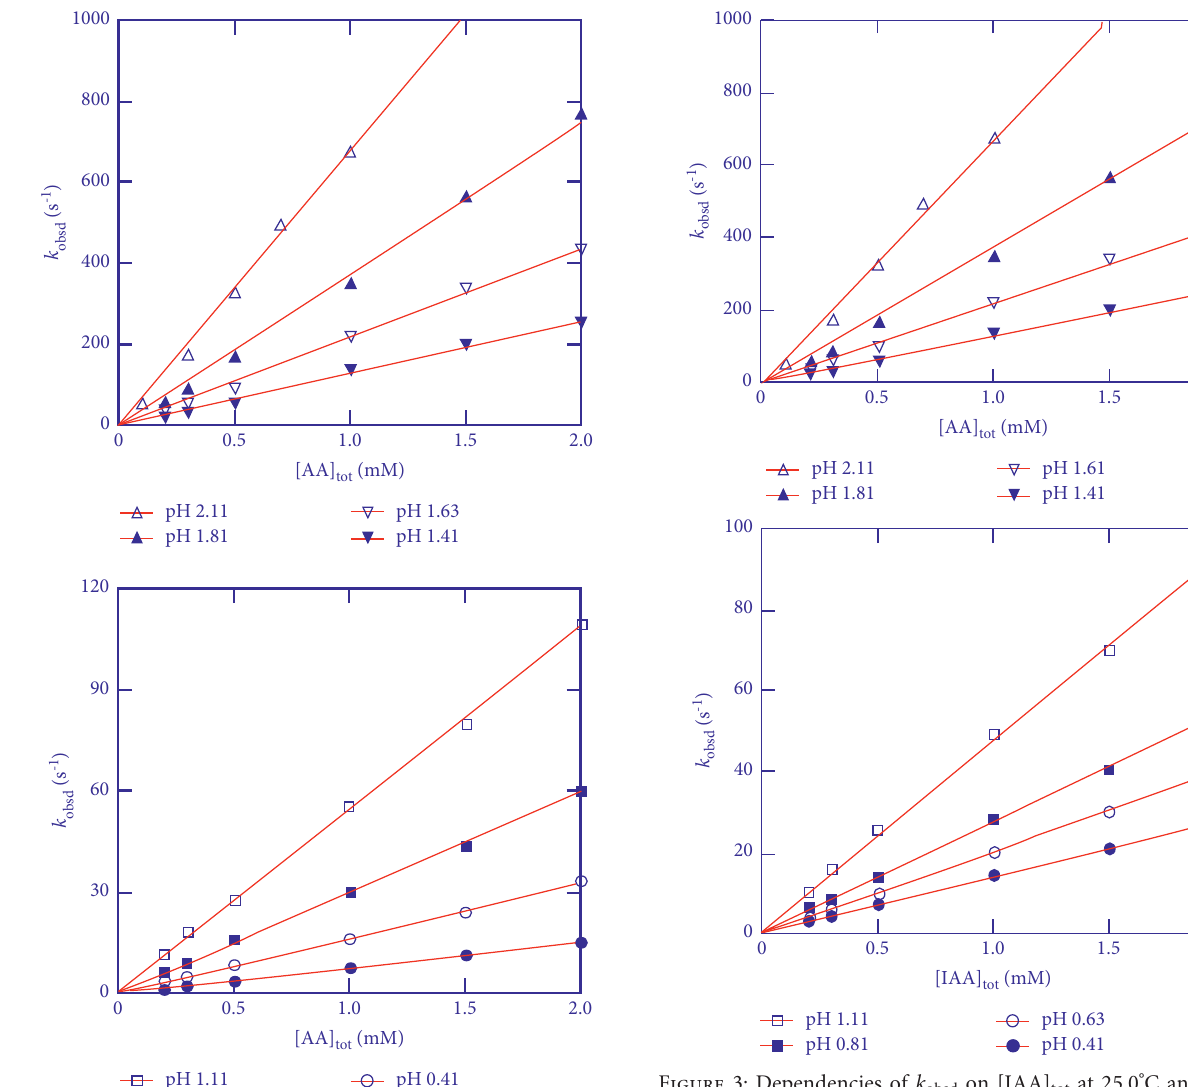
° C and 1.0M obsd on [IAA] tot at 25.0